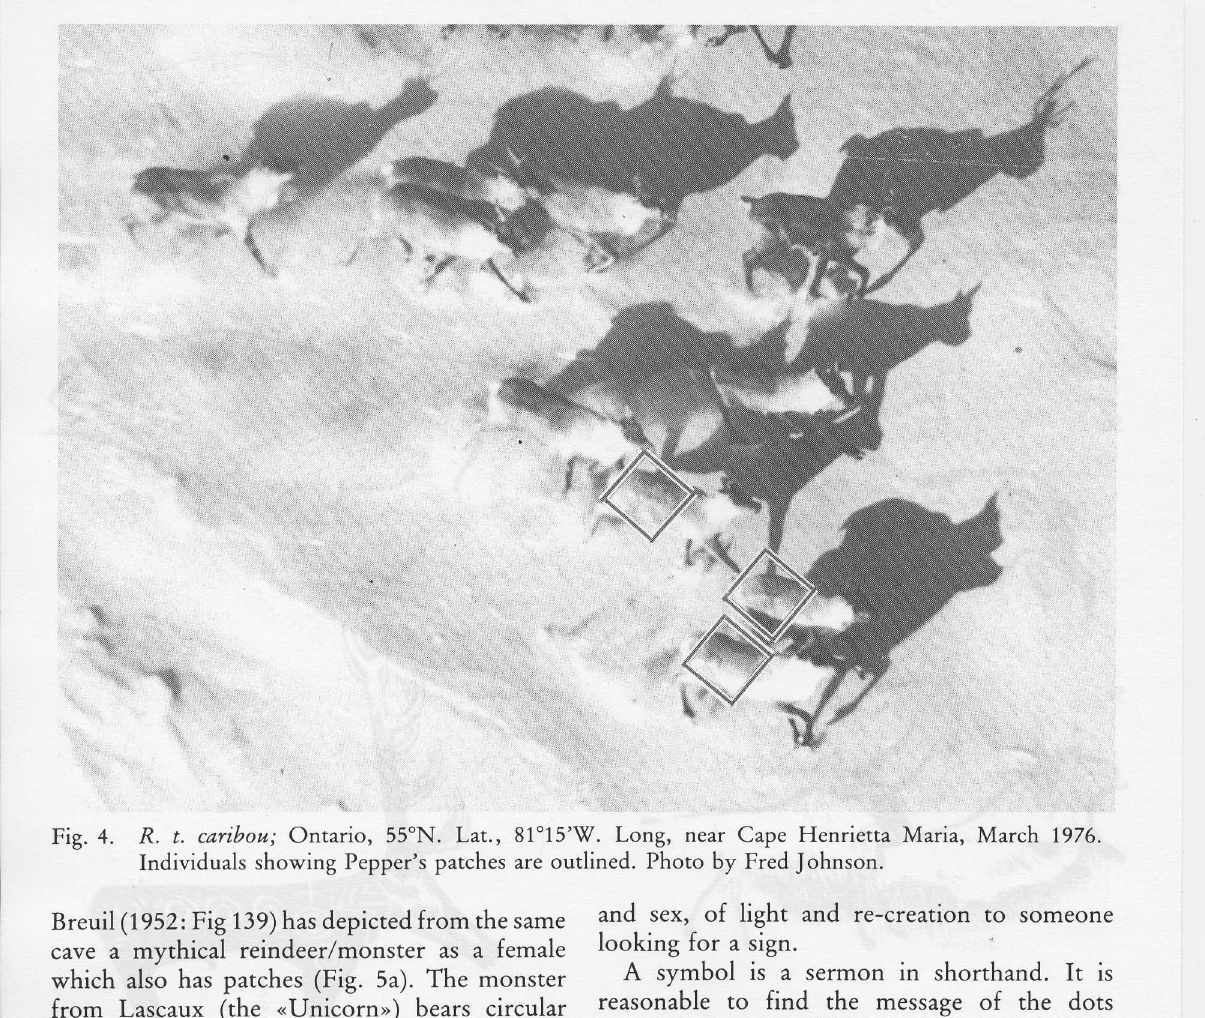
Fig. 4. R. t. caribou; Ontario, 55°N. Lat., 81°15'W. Long, near Cape Henrietta Maria, March 1976. Individuals showing Pepper's patches are outlined. Photo by Fred